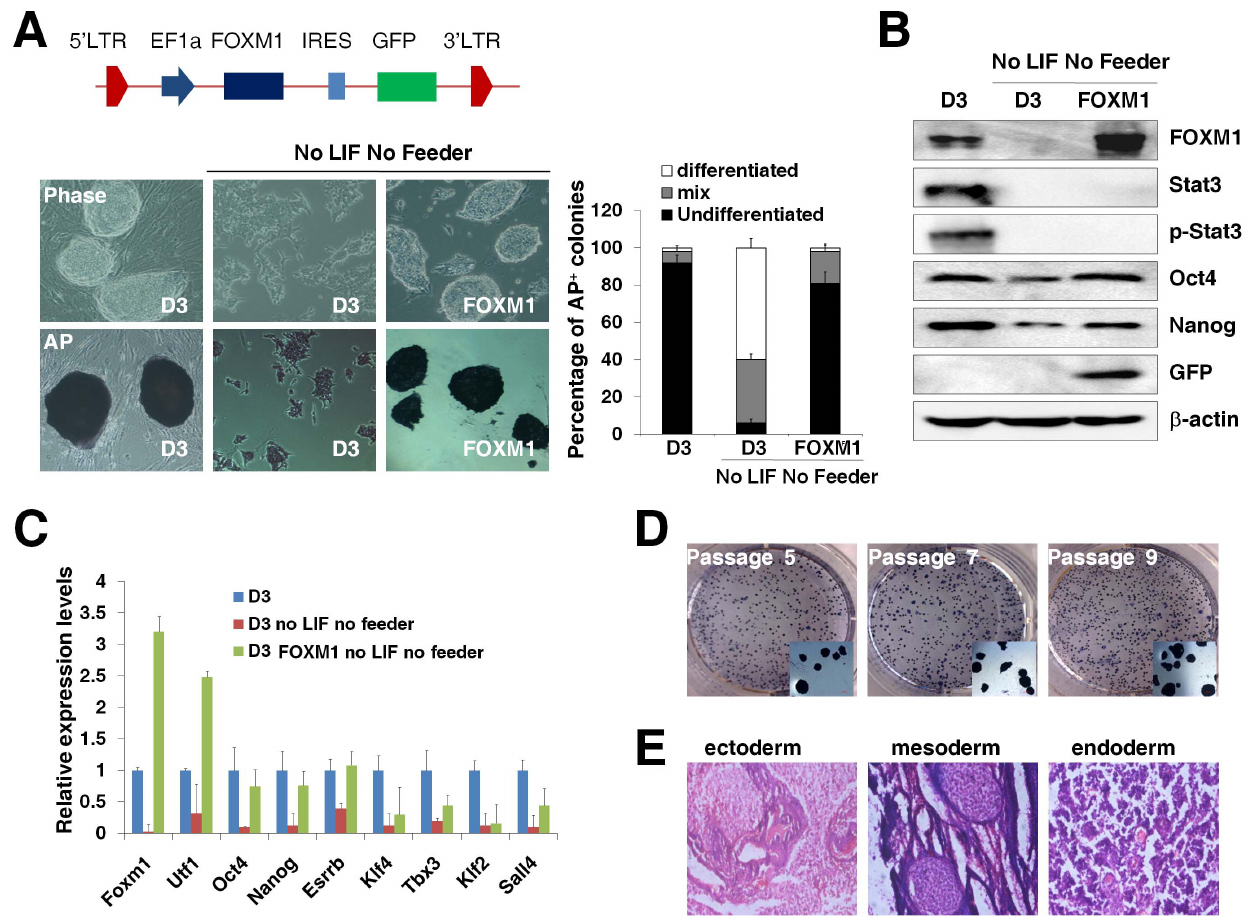
Figure 4. Overexpression of FOXM1 is sufficient to maintain the pluripotency of mESCs in the absence of LIF and feeder layers. (A) The upregulation of FOXM1 expression maintained the typical mESC morphology and positive alkaline phosphatase staining in D3 ES cells in the absence of LIF and feeder layers. A lentiviral vector expressing human FOXM1B was produced to infect D3 ES cells and the lentivirus-infected D3 ES cells were cultured for one week in the absence of LIF and feeder layers. Pictures were taken at 200 6 magnification using a TE2000 microscope (Nikon). Alkaline phosphatase staining (AP) was performed in D3 ES cells, D3 ES cells or FOXM1-overexpressing D3 ES cells cultured without LIF and feeders for one week. The percentage of differentiated, mix, or undifferentiated colonies of different D3 ES cell samples was calculated. (B) The FOXM1 upregulation recovered the levels of Oct4 and Nanog in D3 ES cells in the absence of LIF and feeder layers. Western blot analyses were performed for the expression of Foxm1 (FOXM1), Stat3, phosphorylated Stat3 (p-Stat3), Oct4, Nanog, GFP, and b -actin in D3 ES cells, D3 ES cells without LIF and feeders for one week, or FOXM1-overexpressing D3 ES cells without LIF and feeders for one week. (C) The effects of FOXM1 overexpression on the mRNA levels of pluripotency-related genes in D3 ES cells without LIF and feeders at passage 5. Quantitative RT-PCR analyses were performed for Foxm1, Utf1, Oct4, Nanog, Esrrb, Klf4, Tbx3, Klf2 and Sall4 mRNA levels. The levels of each transcript in D3 ES cells were set at 1.0. Error bars indicated standard deviation (n=3). (D) The typical mESC morphology and positive alkaline phosphatase staining were maintained in FOXM1 overexpressing D3 ES cells during long-term culture without LIF and feeders. Pictures were taken for FOXM1 overexpressing D3 cell culture without LIF and feeders at passage 5, passage 7, and passage 9. The colonies of typical positive alkaline phosphatase staining were shown in the squares of each picture. (E) The teratomas formed by FOXM1 overexpressing D3 ES cells without LIF and feeders at passage 5 contained derivatives of all three germ layers. Sections of the formed teratomas were stained with hematoxylin and eosin dyes and the representative photographs were taken using a TE2000 microscope.